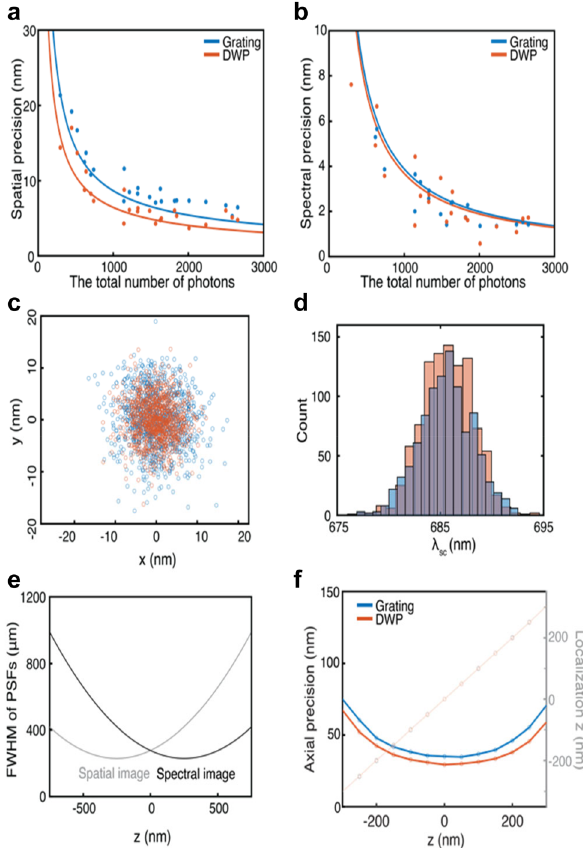
Figure 3: DWPperformanceevaluationusingnumericalandanalytical